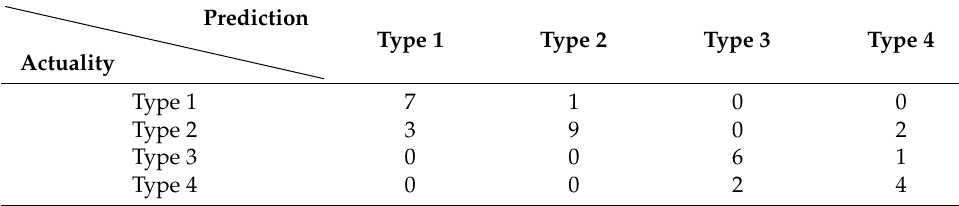
Table 4. Confusion matrix of the SVM classifier.